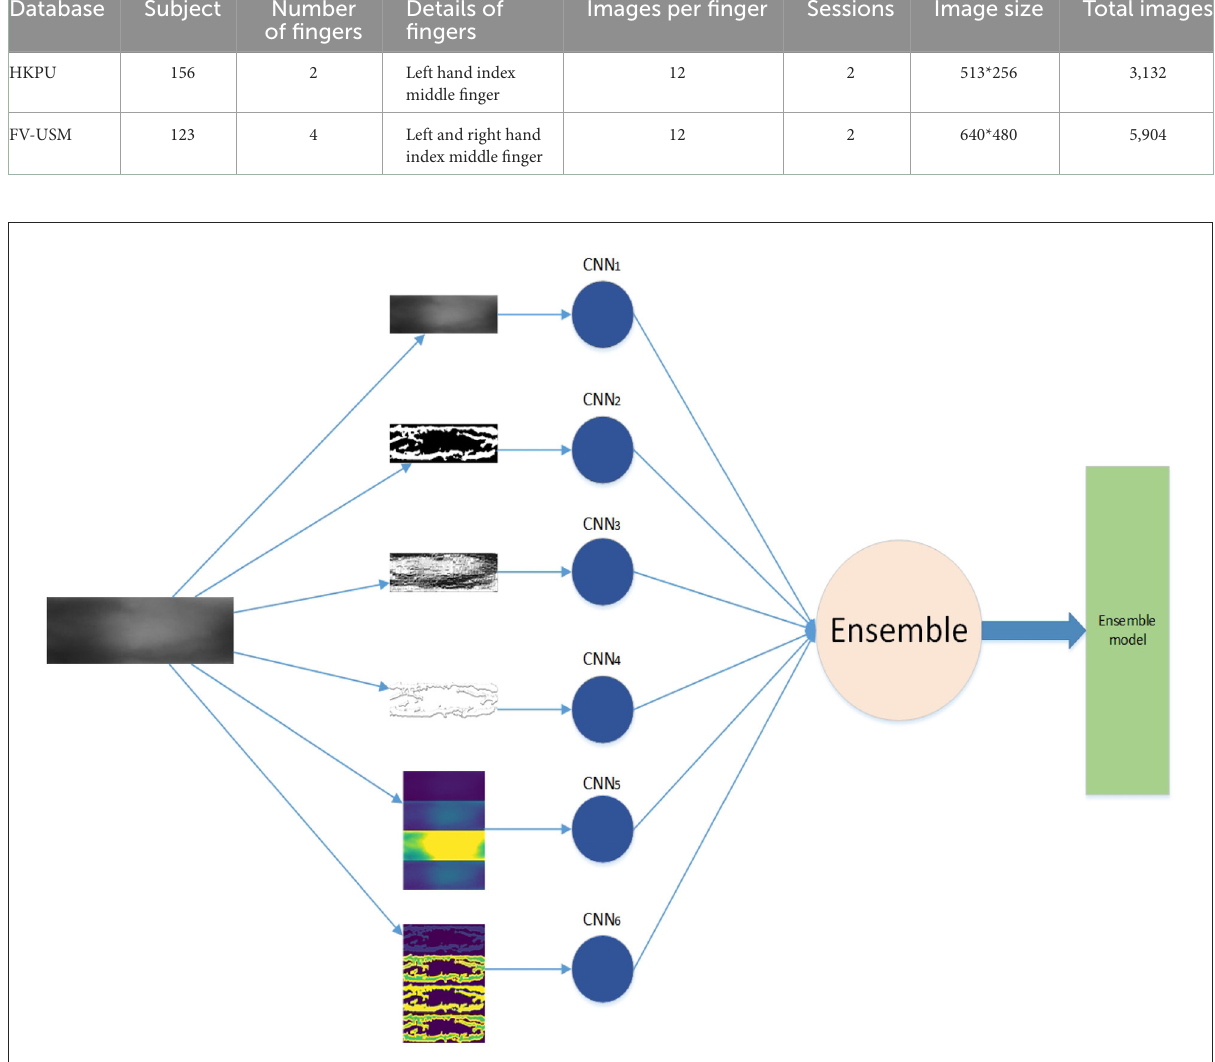
FIGURE8 Training structure of basic